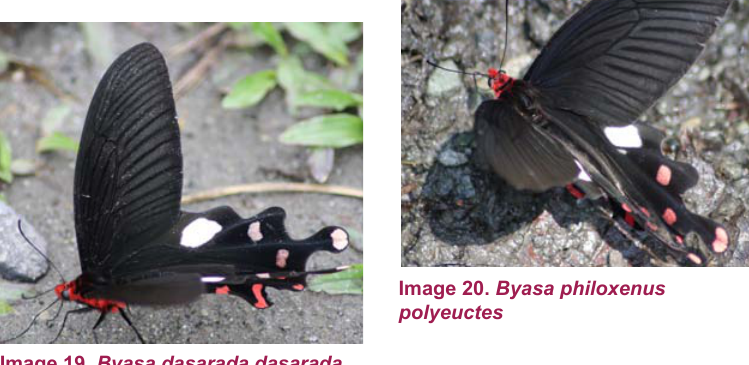
Image 19. Byasa dasarada dasarada